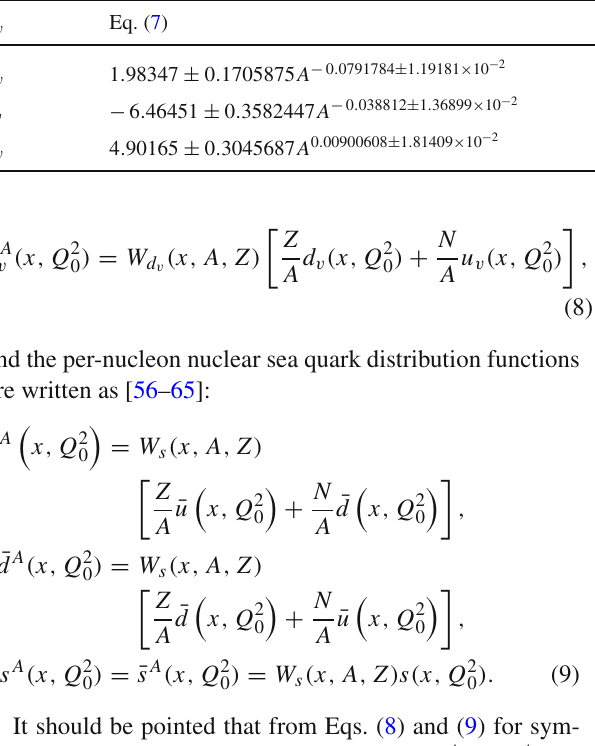
= 2 GeV 2 extracted from Ref. 0